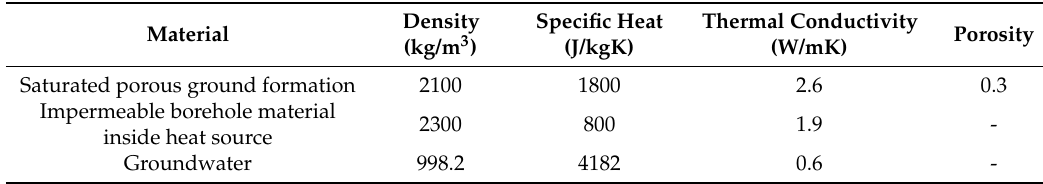
Table 2. Properties of materials for numerical